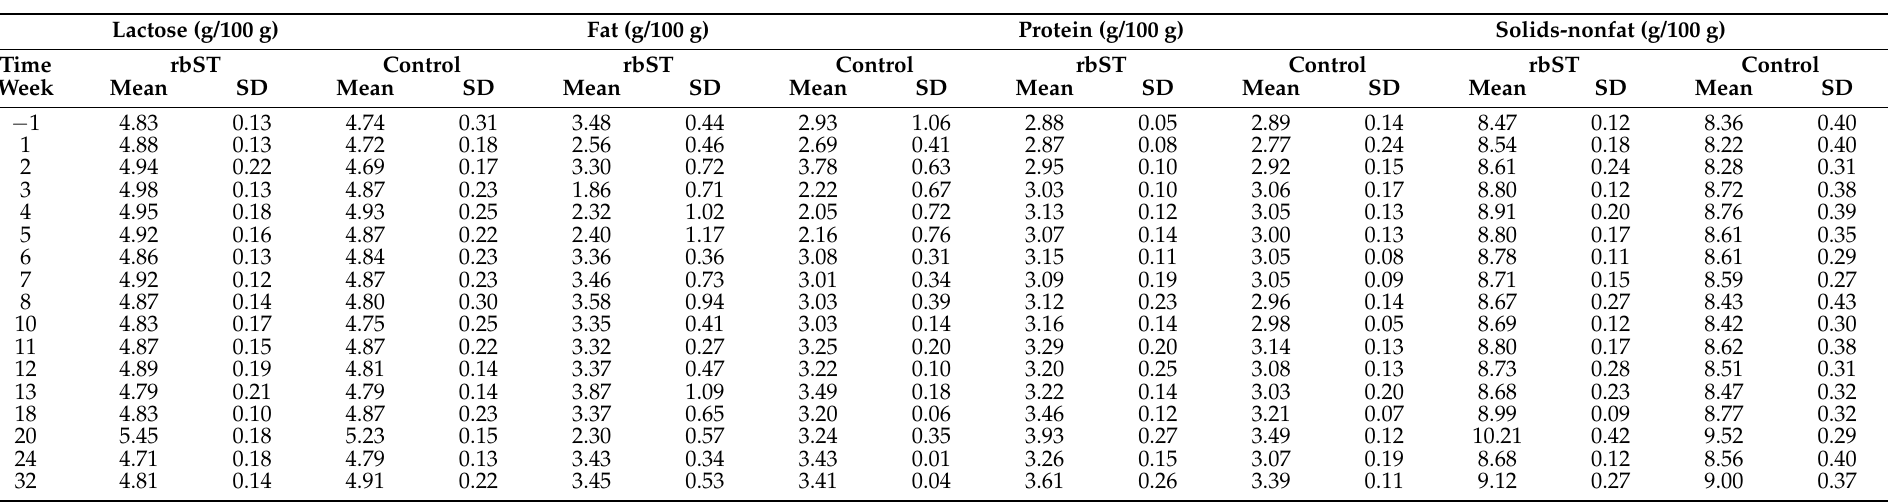
Table 11. Composition of milk obtained from cows treated with recombinant bovine somatotropin (rbST) ( n = 6) and from control animals ( n = 3) at different time points selected over the course of 37 weeks (8 injections of Lactotropina manufactured by Elanco, Eli Lilly, Mexico). Lactose (g/100